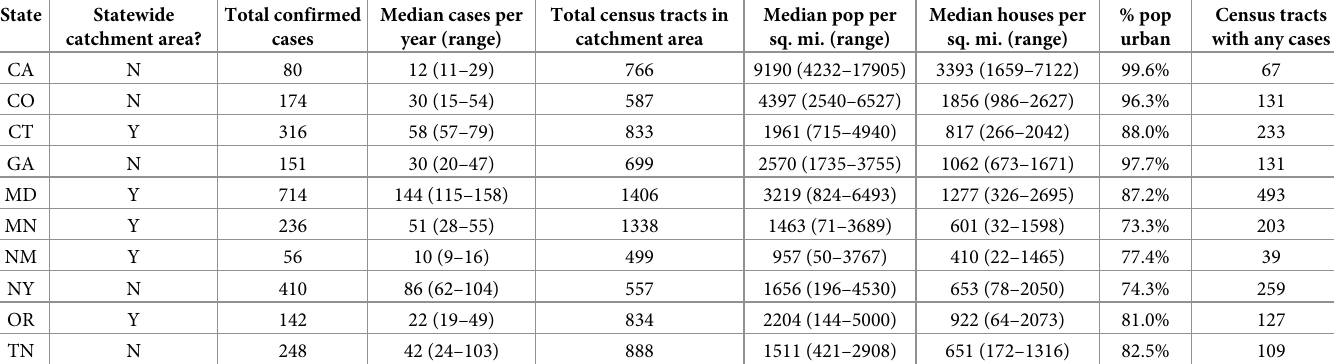
Table 1. Descriptive information on confirmed LD cases by ABCs catchment area (2011–2015).